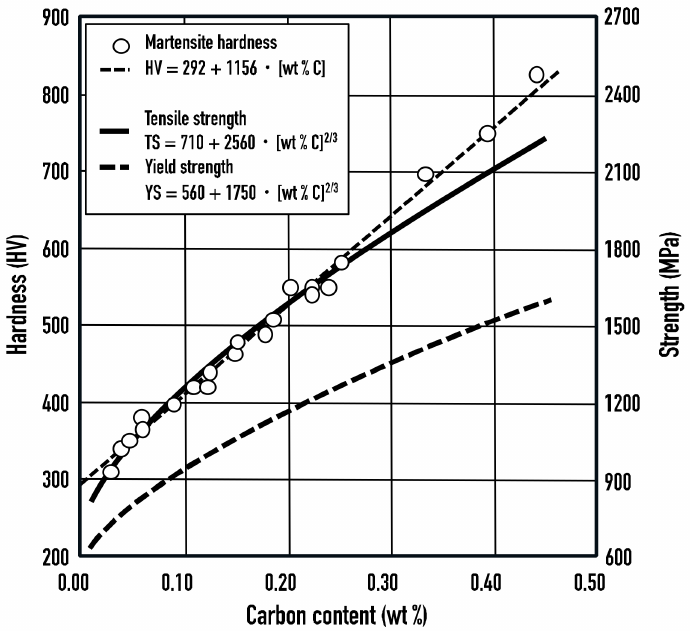
Figure 3. Effect of carbon content on measured hardness (HV0.5) [41] and calculated strength [42] in unalloyed CMn steel with as-quenched martensitic